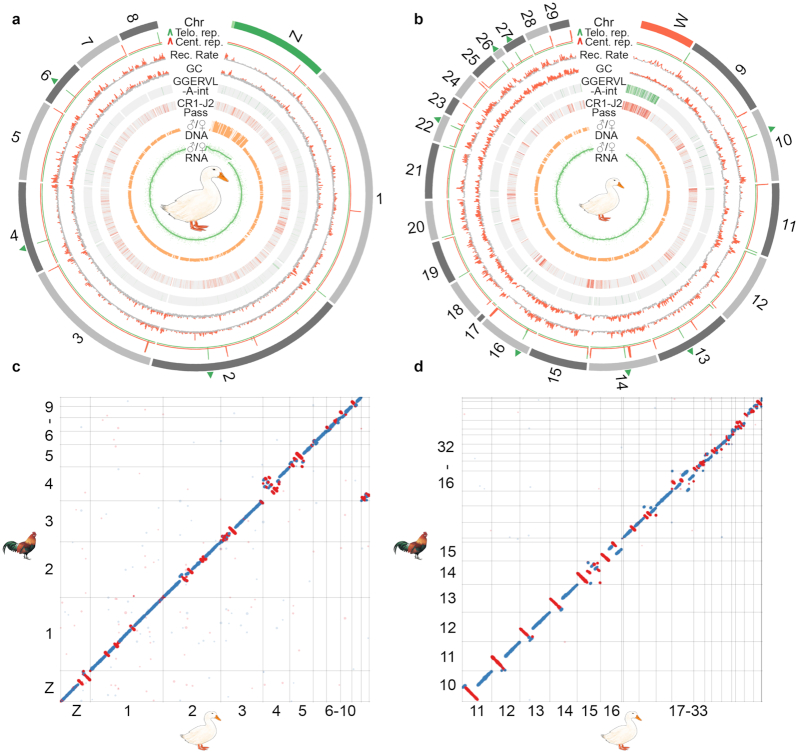
Evolution of the duck macro- and microchromosomes. From the outer to inner rings: the macro- (a) and microchromosomes (b), together with Z/W chromosomes (green/red), and the pseudoautosomal regions (PARs) labeled with light green at the tip of chrZ. Interstitial telomere sequences are labeled with green triangles on the chromosome. Putative centromeres (red lines) and telomeres (green lines) were inferred by the enrichment of centromeric and telomeric repeat copies, which show a sharp peak. We then show the recombination rate and GC content calculated in non-overlapping 50-kb windows, as well as 2 repeat families (GGERVL-A-int and CR1-J2 Pass) that we identified to be enriched at centromeric regions and chrW. We also show the male vs female (M/F) ratios of Illumina DNA sequencing coverage in non-overlapping 50-kb windows, M/F expression ratios (each green dot as 1 gene) of the adult brain tissue, and the smoothed line. c, d. Dot plots show the inversions between chicken and duck genome for both macro- and microchromosomes.